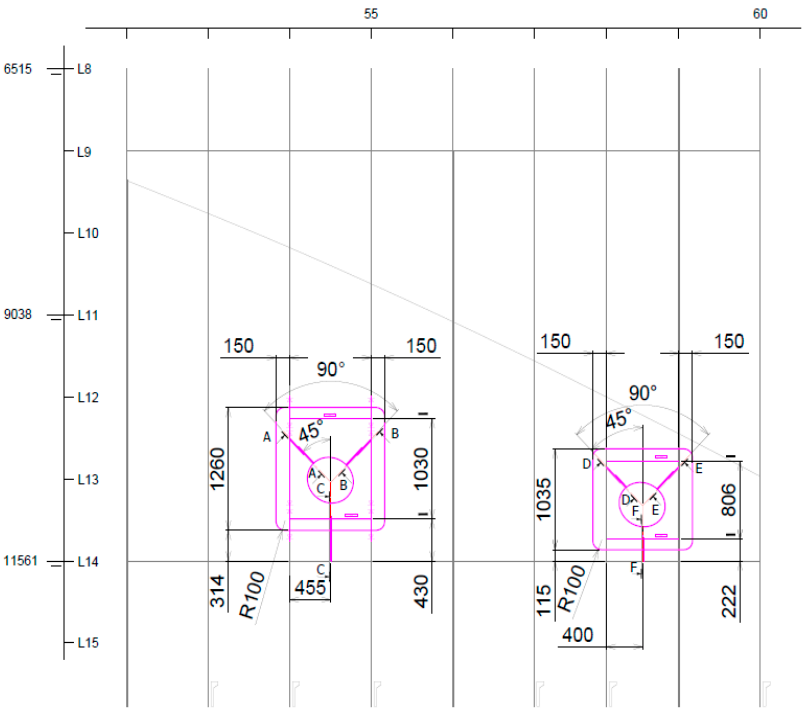
Figure 2. Shell penetration plan for scrubber outlet.